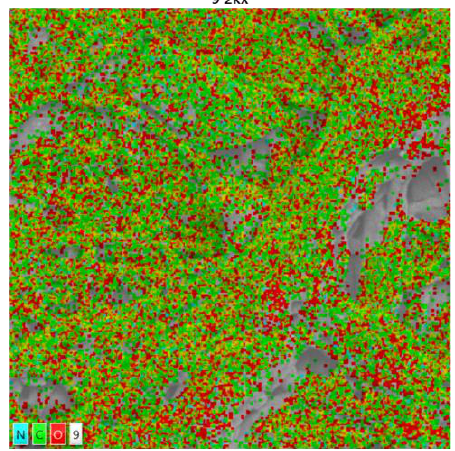
Figure 7. Micrograph of EC after the recycling process. Table 5. Physicochemical characterization of the ECFe sample after treatment.